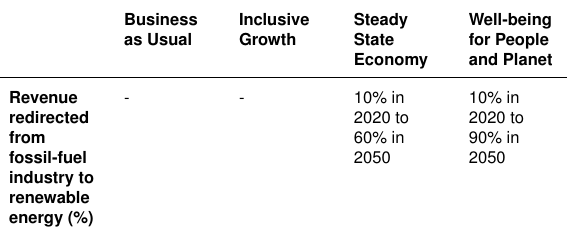
Table 10. Redirecting Income from Fossil-Fuel Industry to Renewable Energy Investment in different